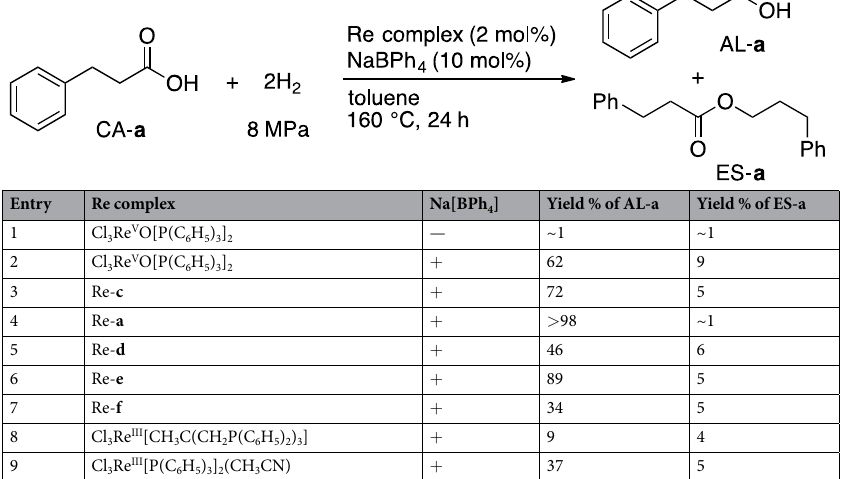
Table 1. Re complexes for the catalytic hydrogenation of CA- a . Unless otherwise specified: CA- a